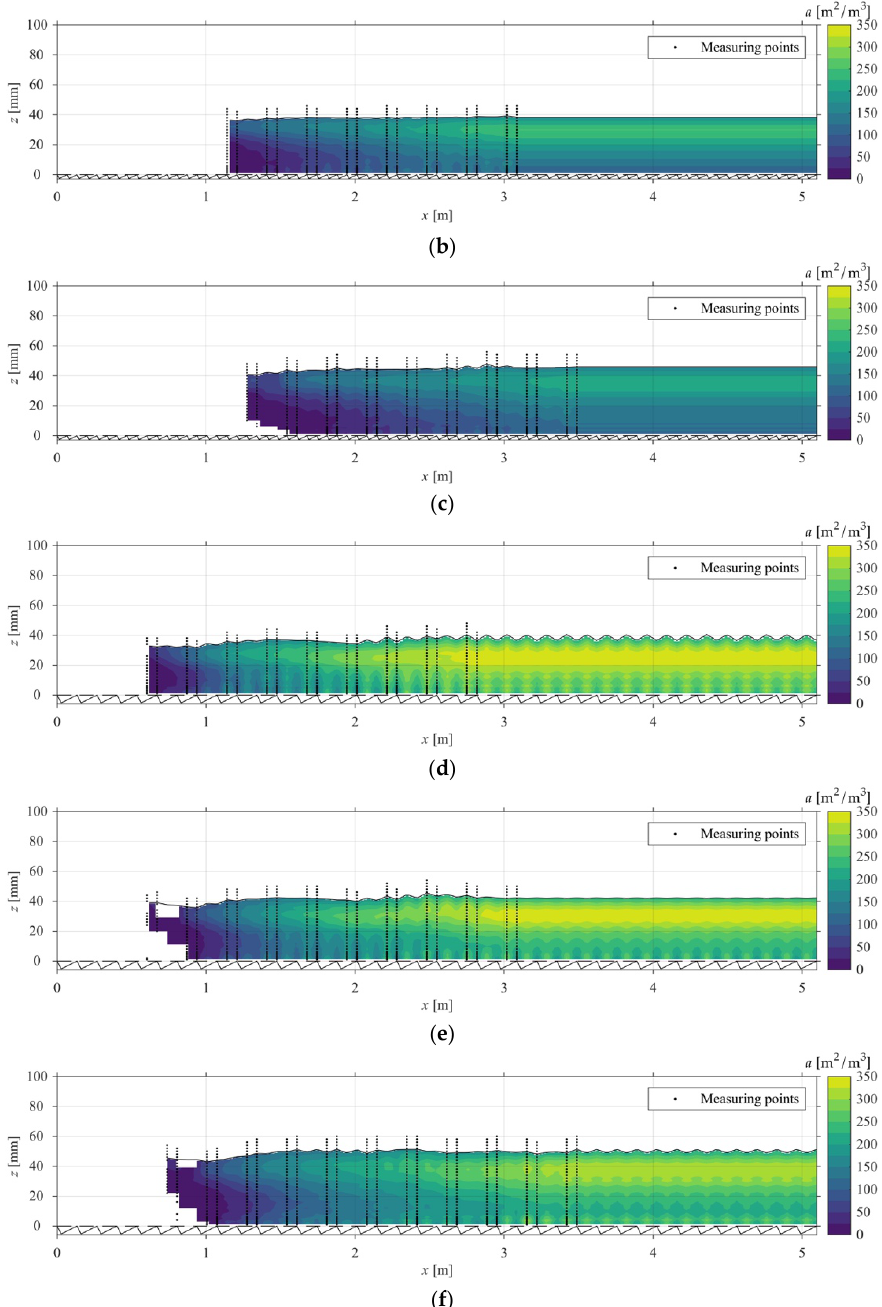
Figure 4. Specific air-water interface a (in m 2 /m 3 ) for all configurations with slope 1:2; downstream of the inception point of self-aeration and from z = 0 (pseudo-bottom) to h 75 ; data in quasi-uniform flow region assumed similar to the last two profiles: ( a ) s = 3 cm, q = 0.07 m 2 /s; ( b ) s = 3 cm, q = 0.09 m 2 /s; ( c ) s = 3 cm, q = 0.11 m 2 /s; ( d ) s = 6 cm, q = 0.07 m 2 /s; ( e ) s = 6 cm, q = 0.09 m 2 /s; ( f ) s = 6 cm, q = 0.11 m 2 /s.